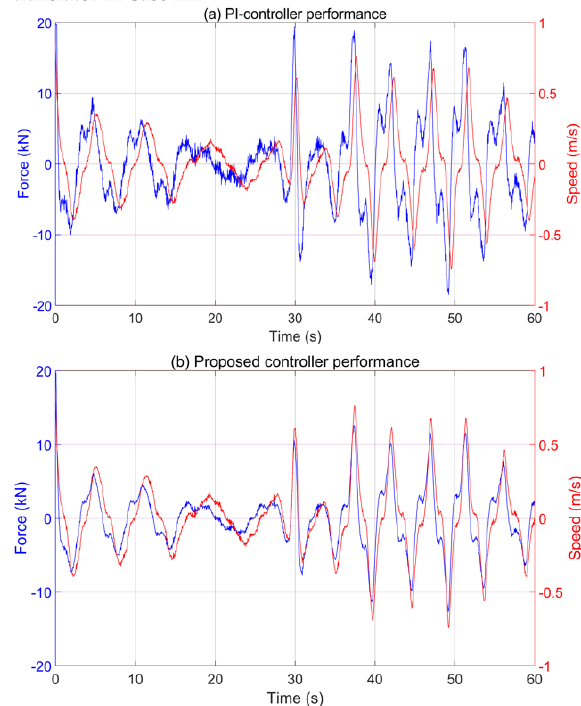
Fig. 10. The acting force and speed in Case II and Case III of the irregular translator motions. (a) PI-controller performance; (b) Proposed control